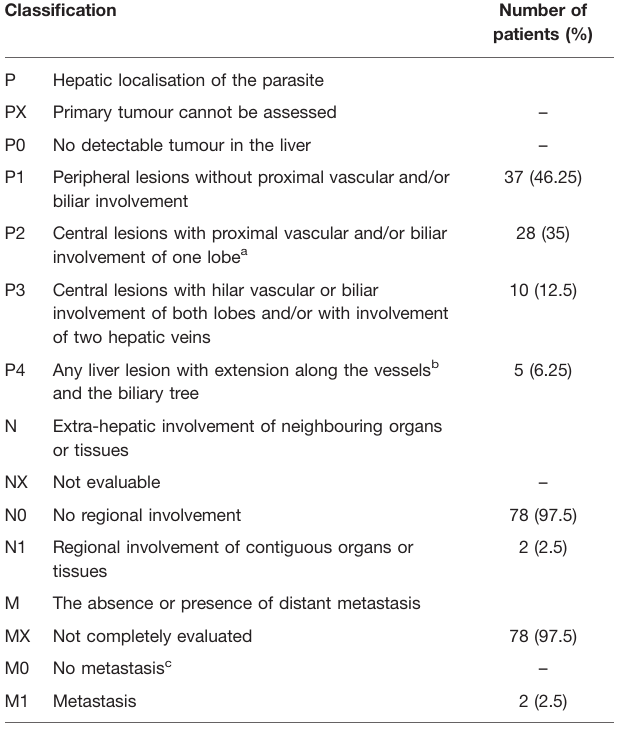
TABLE 4 | PNM system for classi fi cation of human alveolar echinococcosis. Classi fi cation